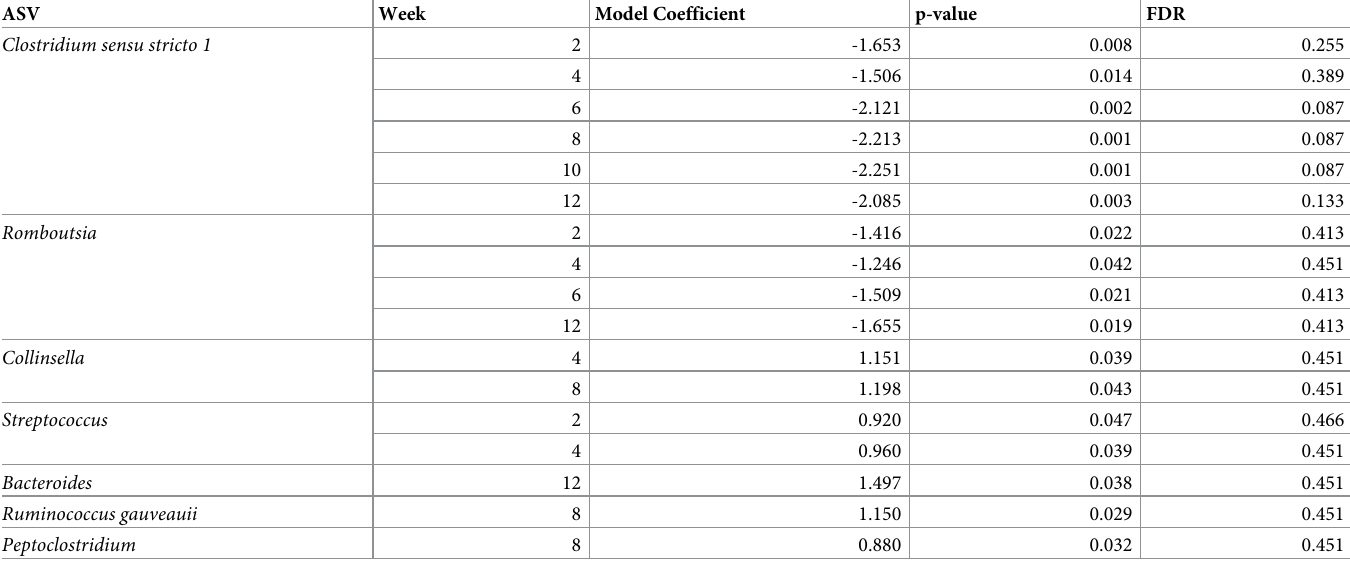
Table 2. ASVs with significant relative abundance associations with various time points.